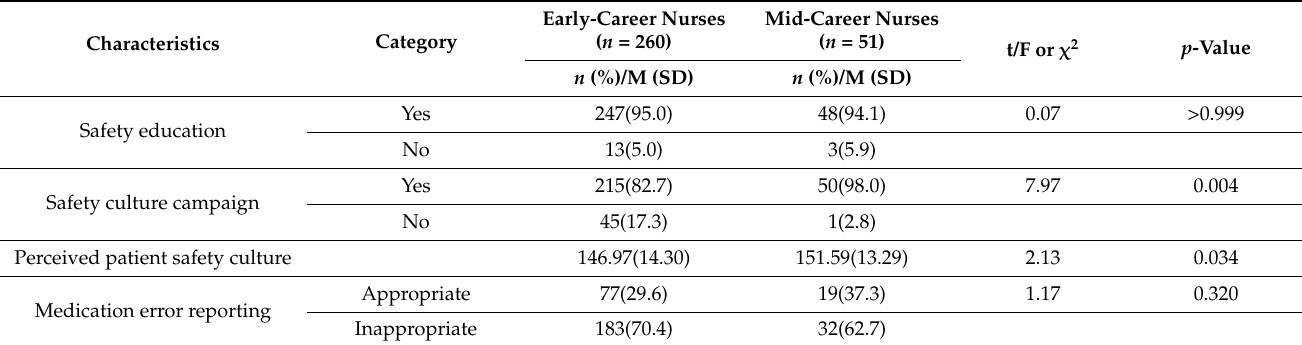
Table 2. Comparison of patient safety culture-related variables between early- and mid-career nurses.